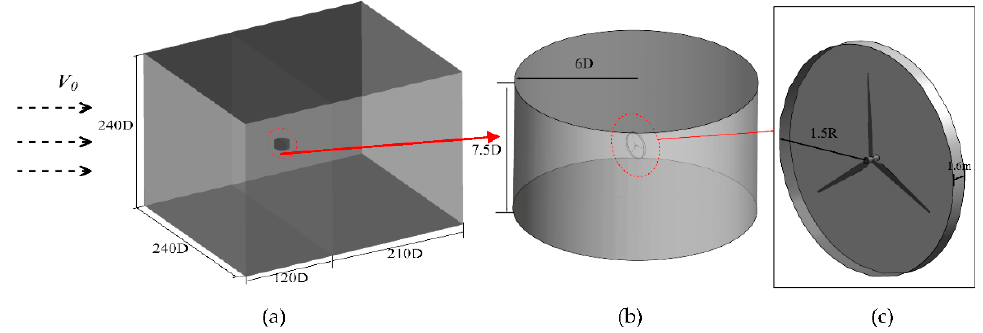
Figure 2. Computational Zones: ( a ) far-field (static); ( b ) yaw zone; ( c ) rotational zone.